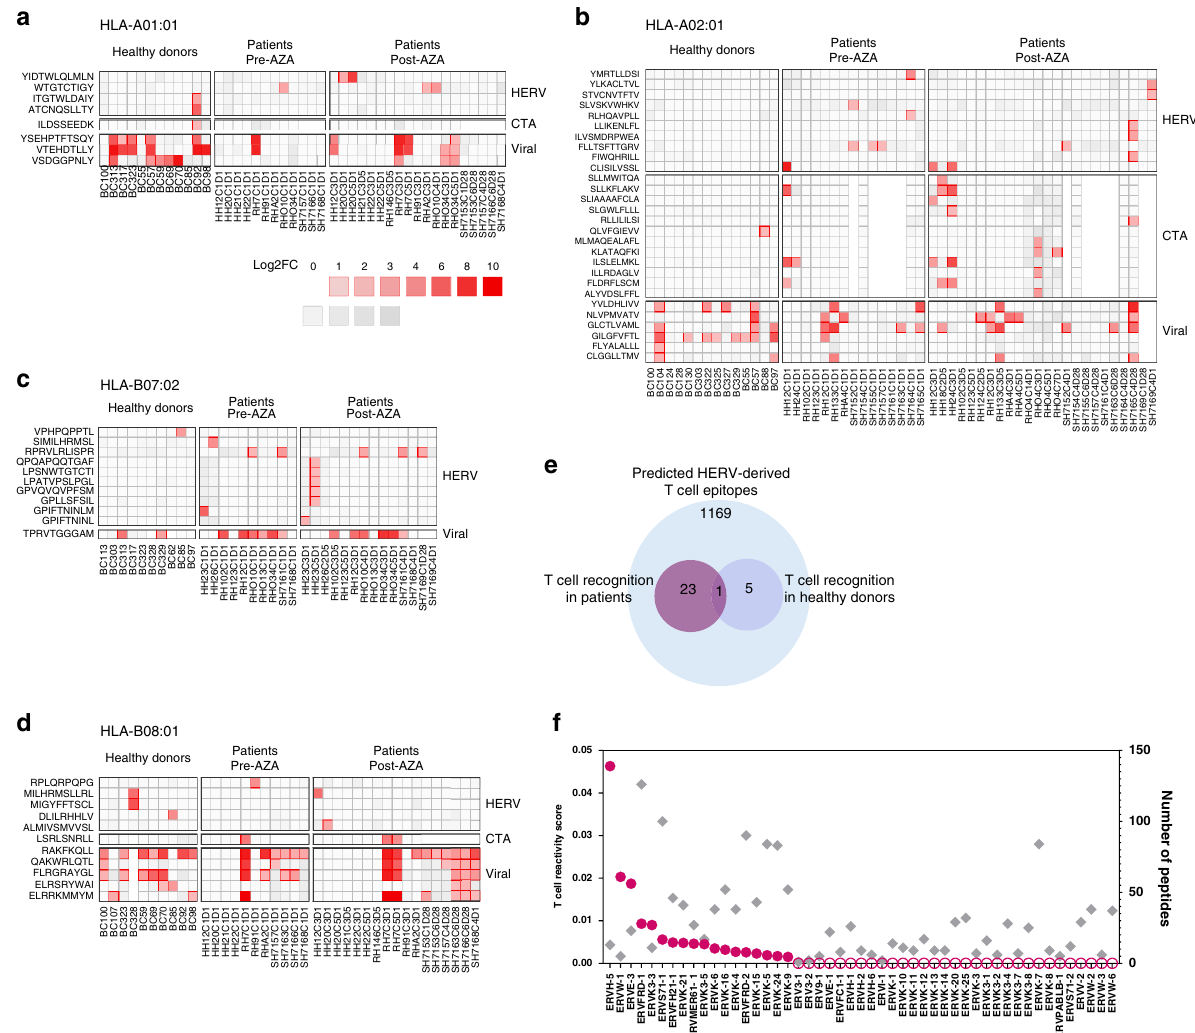
Fig. 2 T cell reactivity to HERV-derived peptides in myeloid malignancies. T cells reactive to HERV-derived peptides, CTAs, and viral antigens were identi fi ed from peripheral blood (Danish patients and healthy donors (HD)) and bone marrow (Australian patients) samples using a DNA barcode-based pMHC multimer analysis. a – d Identi fi ed T cell responses are shown across the four tested HLAs for healthy donors and patient samples pre- and post-AZA therapy. Vertical axis labels the sample IDs and the horizontal axis shows the peptide sequences (single letter amino acid codes) split into three categories of antigens (HERV, CTA, and viral). T cell responses are shown based on barcode enrichment (Log2FC) in the sorted population compared to the complete pMHC library, and red scale determines signi fi cant enrichment (FDR < 0.1%) and gray scale if no signi fi cant enrichment was found. Peptides identi fi ed to have a T cell response in at least one of the analyzed samples are included; data for all the tested peptides are shown in Supplementary Fig. 2. The white color indicates peptides not tested in the speci fi c samples. Patient samples with the pre fi x “ RH ” and “ HH ” derive from the Danish patients and patient samples with the pre fi x “ SH ” derive from the Australian patients. e Venn diagram summarizing numbers of immunogenic HERV-derived T cell epitopes identi fi ed in patients and healthy donors. f T cell reactivity score (pink dots, plotted in descending order) and peptide library size (gray diamonds) of individual HERVs analyzed for T cell recognition in the patients. Pink hollow dots represent HERVs with no T cell reactivity. T cell reactivity score is calculated as the sum of all the T cell reactive peptides out of the total peptide library of a given HERV tested across the patient samples. Source data are provided as Source data fi